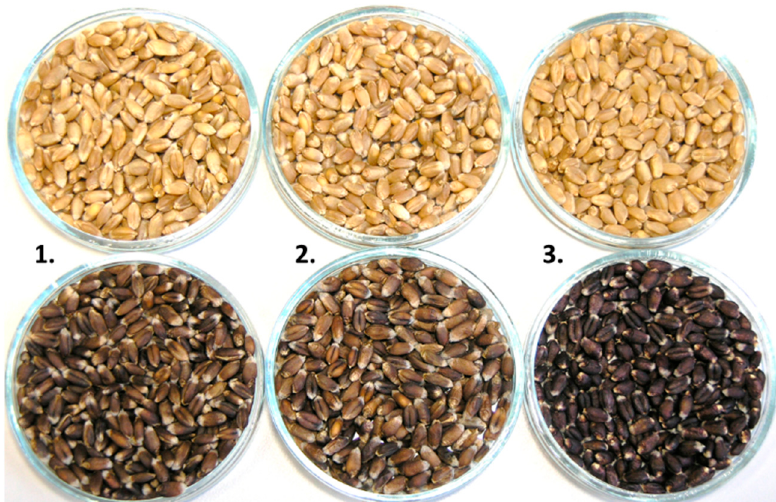
Figure A4. Grains of wheat cultivars/lines without anthocyanins (in the top row) and that of their purple ‐ grained derivatives (in the bottom row). ( 1 ) ‘Saratovskaya 29 ′ and i:S29 PF ; ( 2 ) ‘Element 22 ′ and its BC 1 F 4 line; ( 3 ) BW49880 and its BC 1 F 4 line. Agronomy 2020 , 10 , x FOR PEER REVIEW